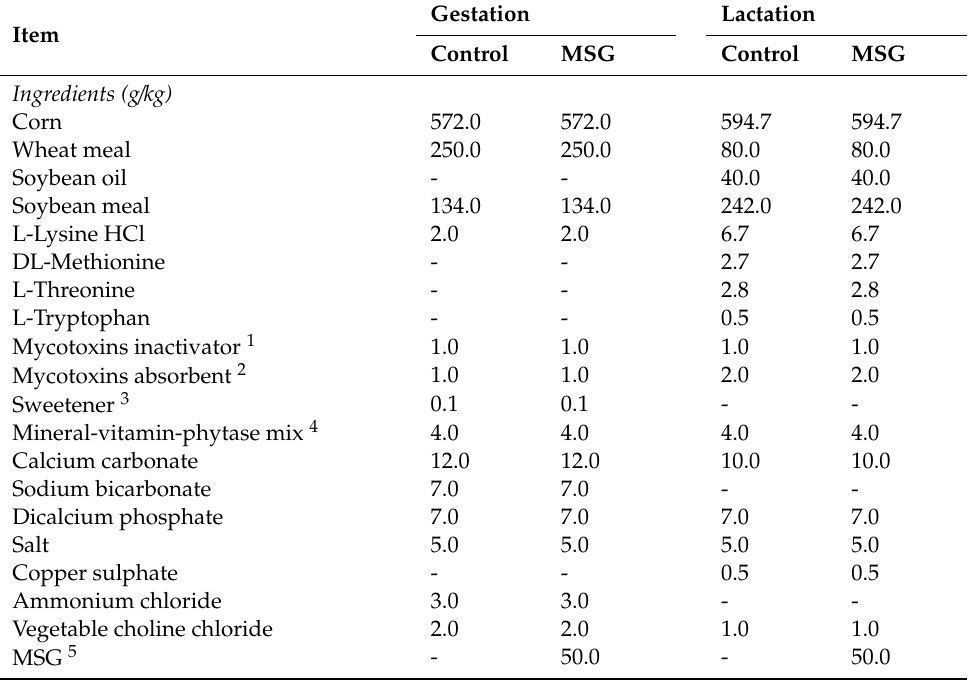
Table 1. Composition and chemical analysis of the gestating and lactating diets of sows used in the